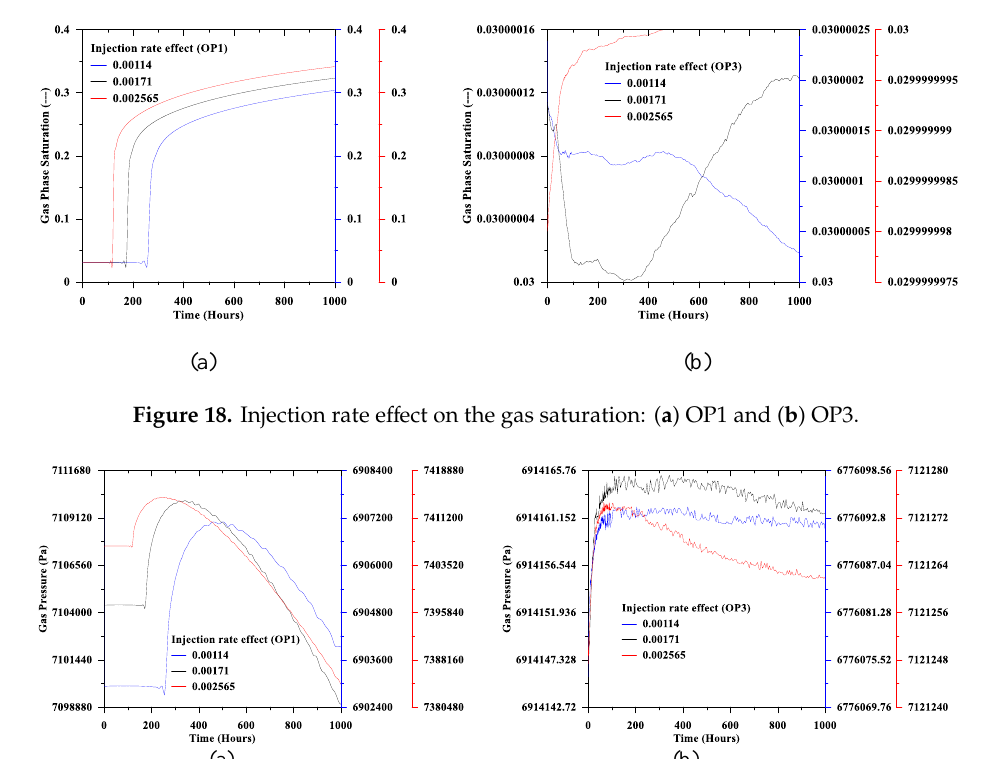
Figure 17. Injection rate e ff ect on the y -axis stress: ( a ) OP1 and ( b ) OP3. Figure 17. Injection rate effect on the y -axis stress: ( a ) OP1 and ( b ) OP3. Figure 17. Injection rate effect on the y -axis stress: ( a ) OP1 and ( b ) OP3. Figure 17. Injection rate effect on the y -axis stress: ( a ) OP1 and ( b ) OP3. Figure 17. Injection rate effect on the y -axis stress: ( a ) OP1 and ( b ) OP3.